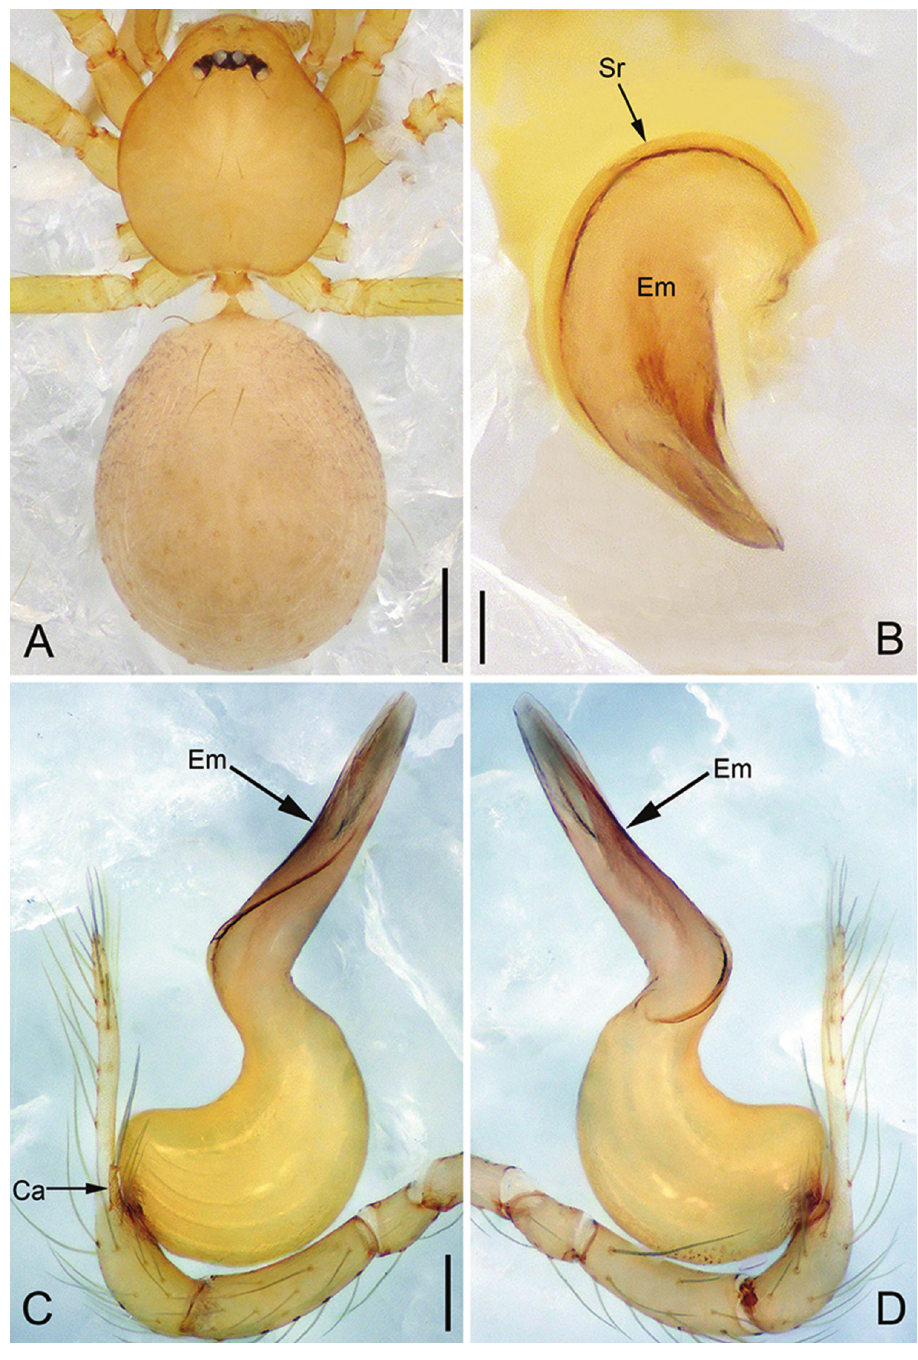
Figure 19. Pinelema wangshang Zhao & Li, sp. n., male holotype. A Habitus, dorsal view B Embolus, apical view C Palp, prolateral view D Palp, retrolateral view. Scale bars: 0.2 mm ( A ), 0.05 mm ( B ), 0.1 mm ( C–D